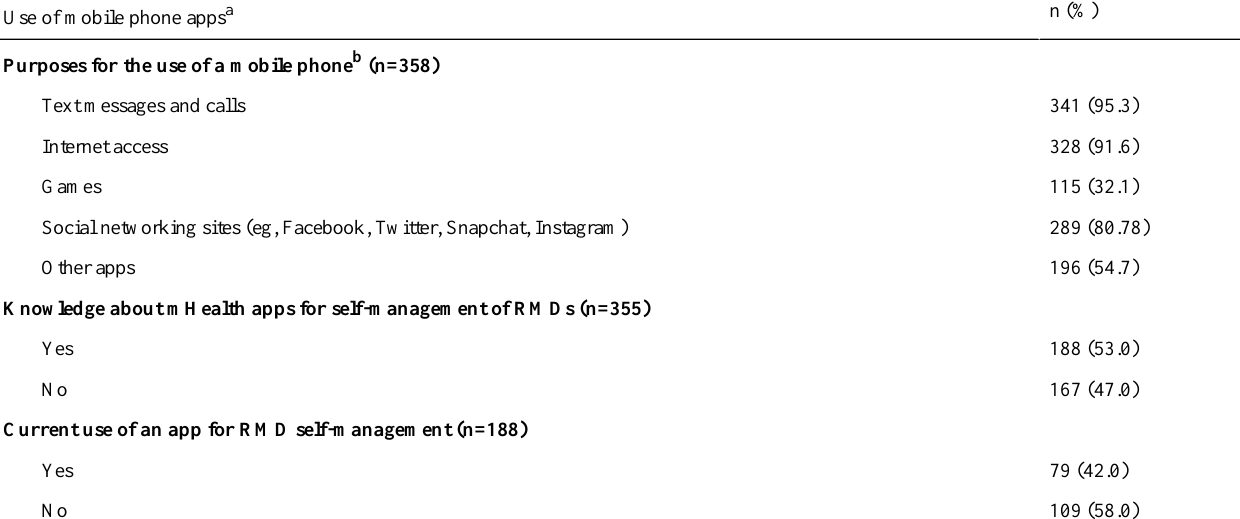
Table 2. Current and past use of mobile phone apps for rheumatic and musculoskeletal diseases (N=358). Purposes for the use of a mobile phone b